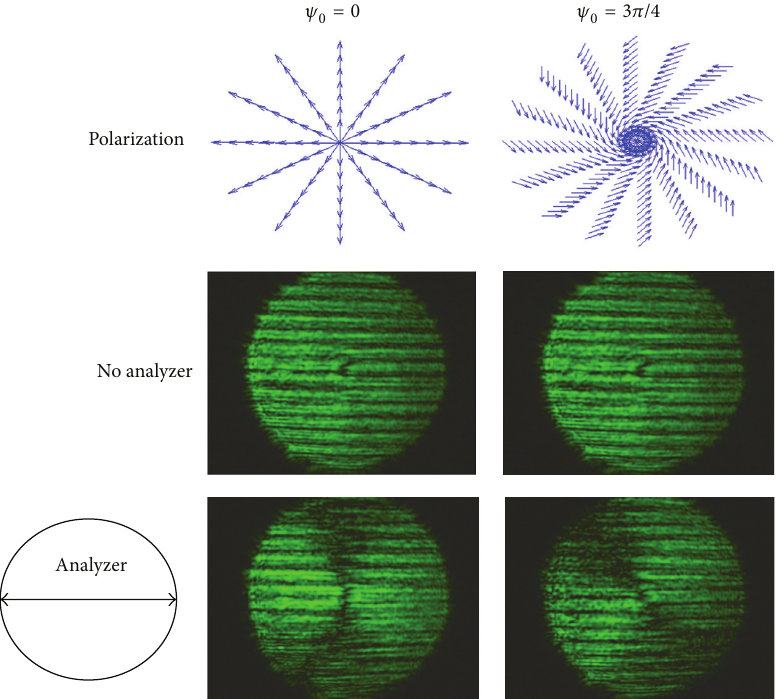
Figure 2: Cylindrical vector beams generated with integer topological charge 𝑚 = 1 and constant phase differences of 𝜓 0 = 0 and 𝜓 0 = 3𝜋/4